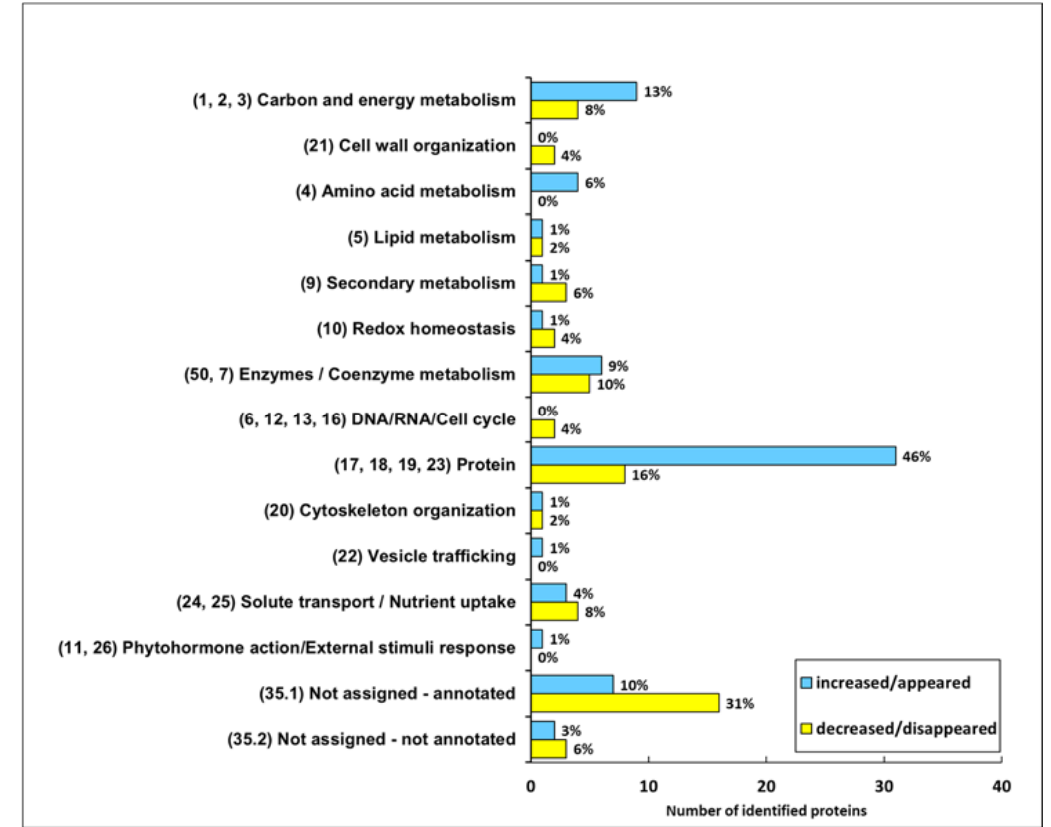
Figure 3. Functional distribution of the differentially accumulated proteins in roots of M4 grapevine rootstock after exposure of the plants to 10 mM NO 3 − . Proteins were grouped in categories according to BIN ontology (codes reported in brackets). The percentage refers to the total number of proteins having the same trend: blue bars, proteins that increased/appeared; yellow bars, proteins that decreased/disappeared.